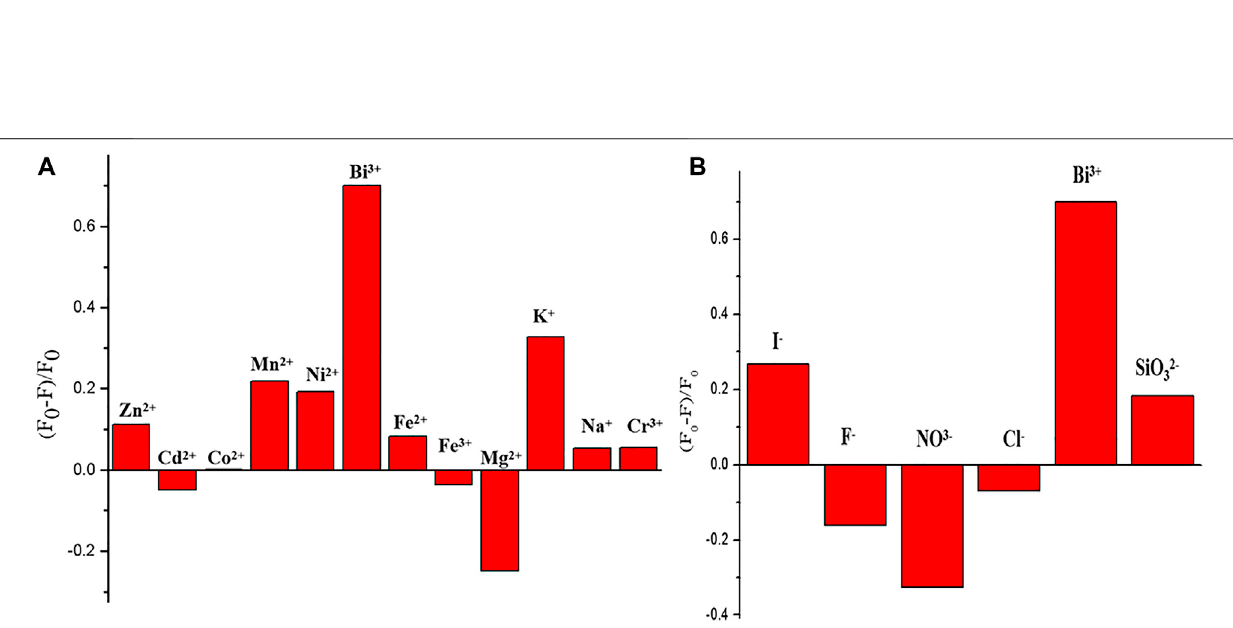
Frontiers in Chemistry |